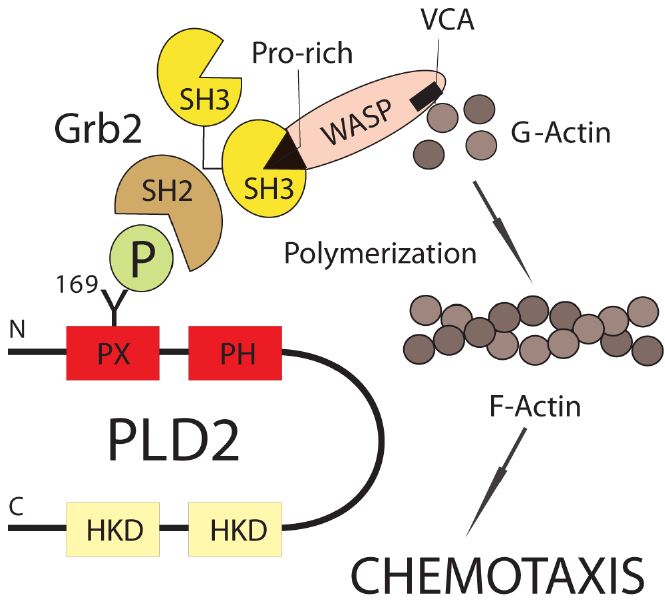
FIGURE 3. Proposed novel model for the action of phosphorylated PLD2 on chemotaxis involving Grb2 and WASP. One of the immediate actions of tyrosyl- phosphorylated, activated PLD2 is its association with Grb2, a docking protein that is known to serve as a nexus for other signaling proteins (Sos in the ERK pathway, etc.). Our laboratory demonstrated that Grb2 binds PLD2 at the 169 Y LNR 172 site through its SH2 domain. It is possible that Grb2 then